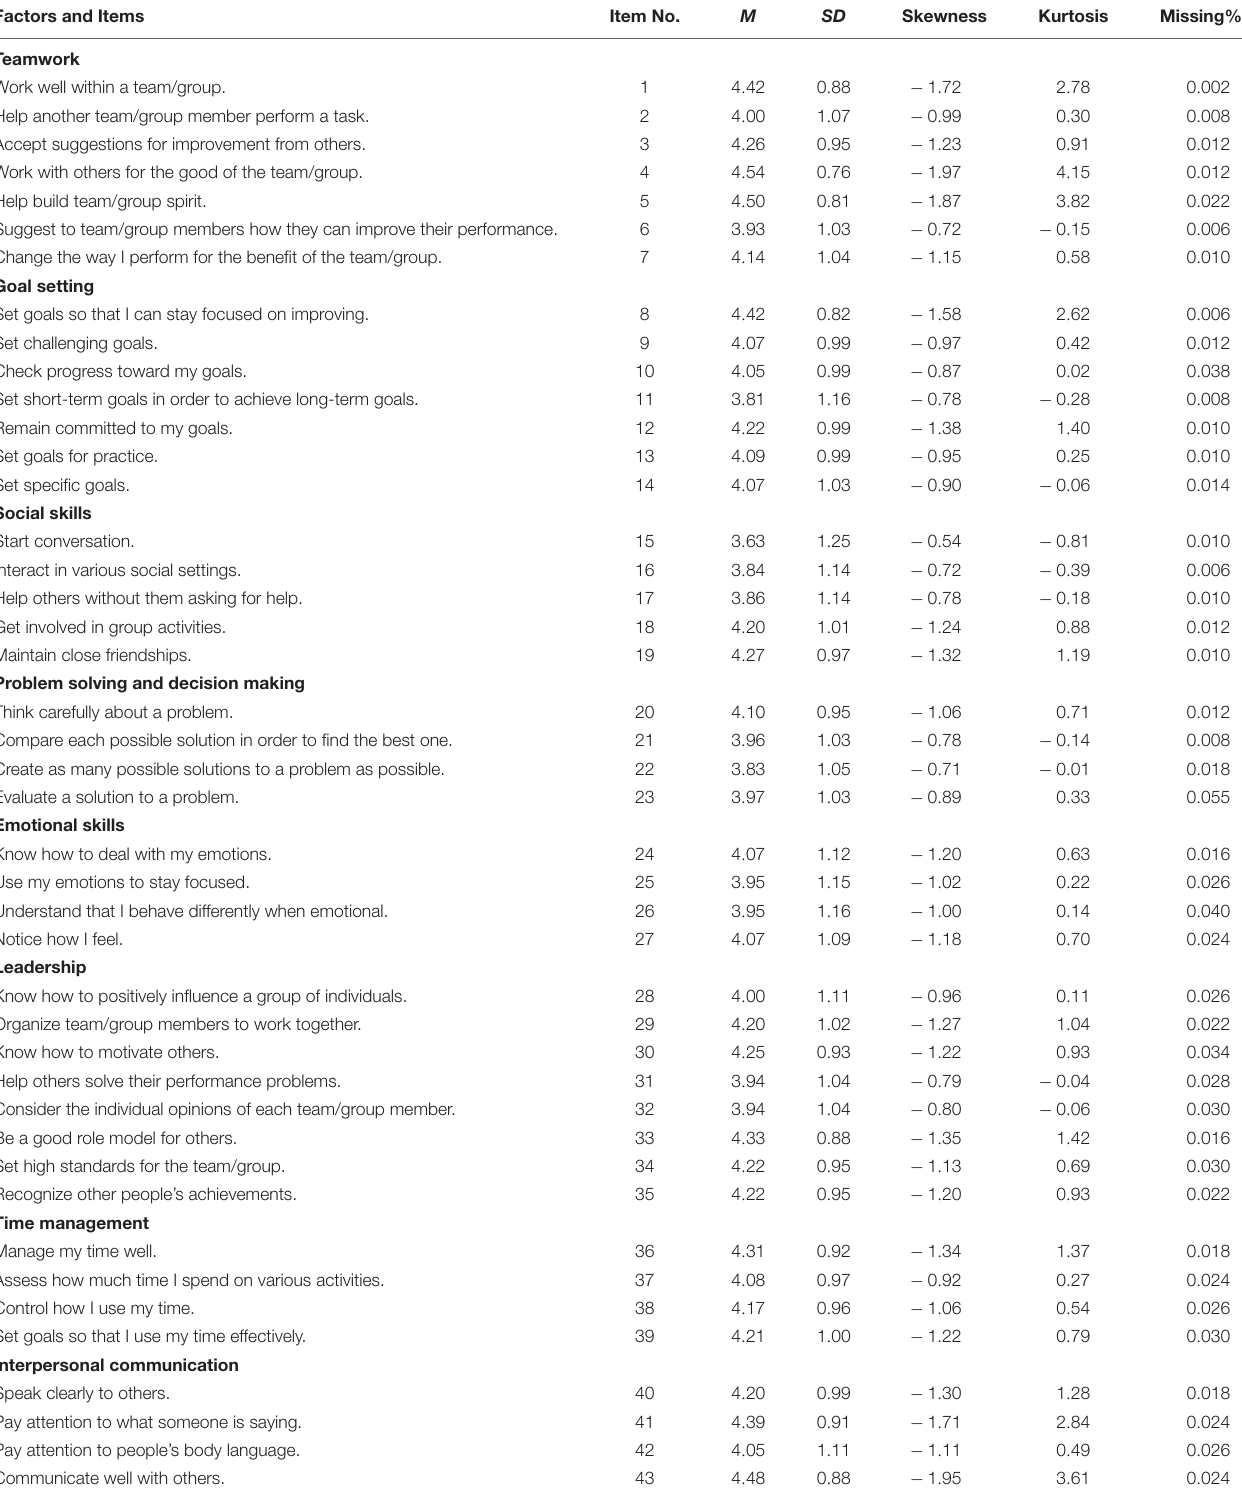
TABLE 1 | Descriptive statistics for the life skill scale for sport items. Factors and Items Item No. M SD Skewness Kurtosis Missing%